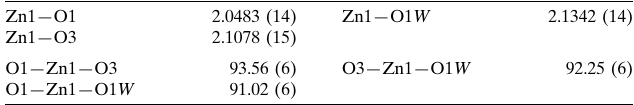
Selected geometric parameters (A˚ , (cid:2) ).